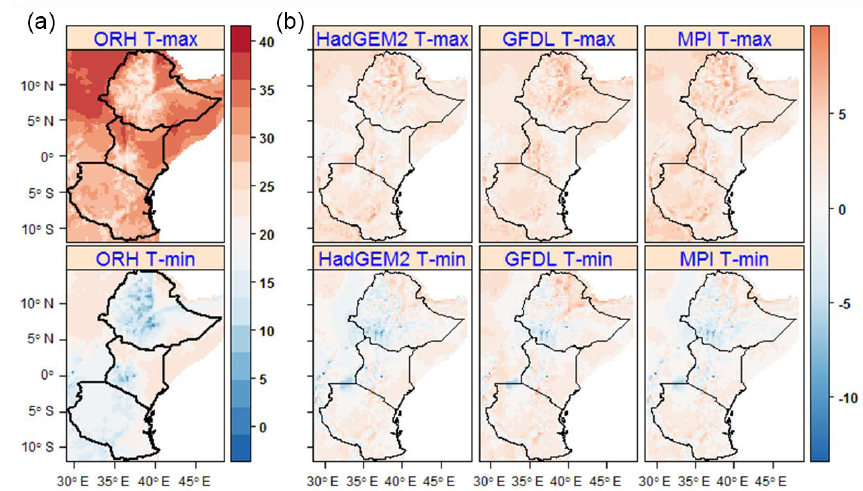
Figure 7. Map of average daily T max and T min ( ◦ C) for East Africa generated from ORH (a) for the study period 1983–2005. For temperature data from HadGEM2, GFDL, and MPI (b) , the absolute difference ( ◦ C) from ORH is displayed. All the maps are given in a 0.1 ◦ spatial